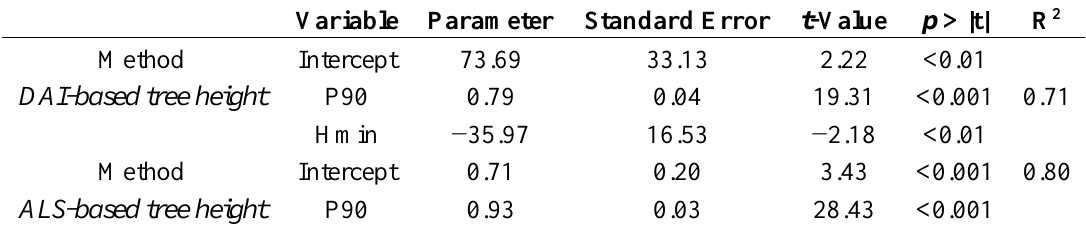
Table 4. Results of the best models obtained for the estimation of tree height from ALS- and DAI-based